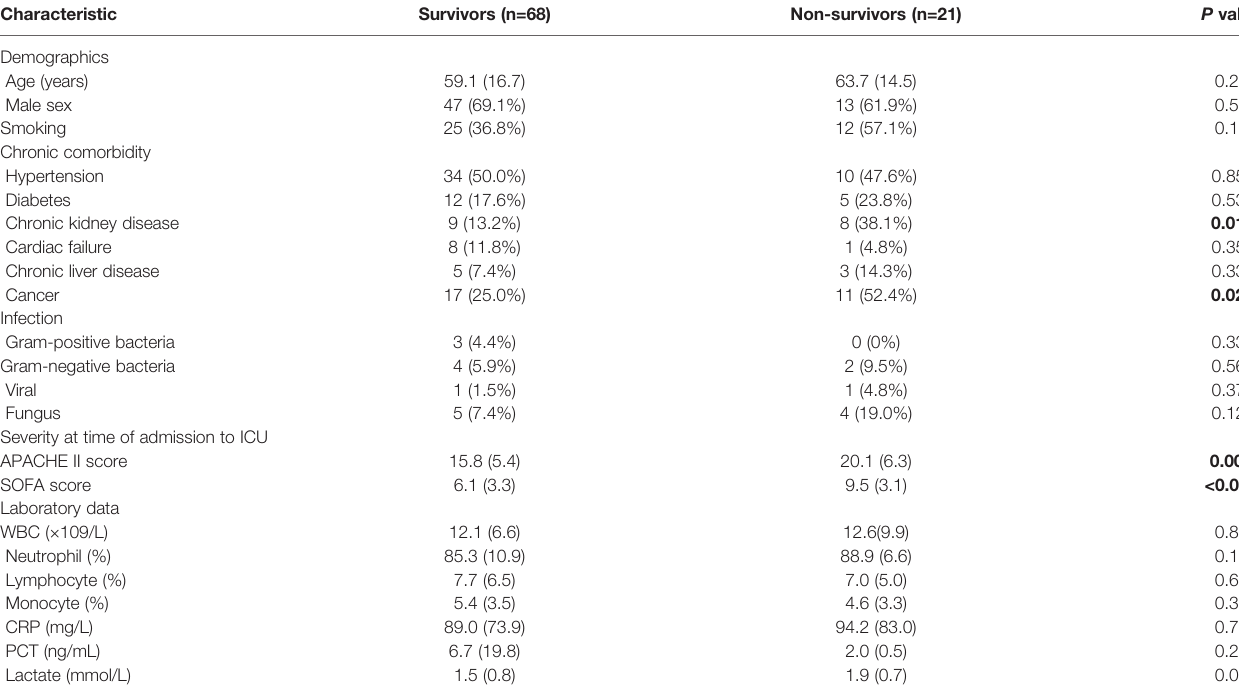
TABLE 1 | Characteristics of patients included in the